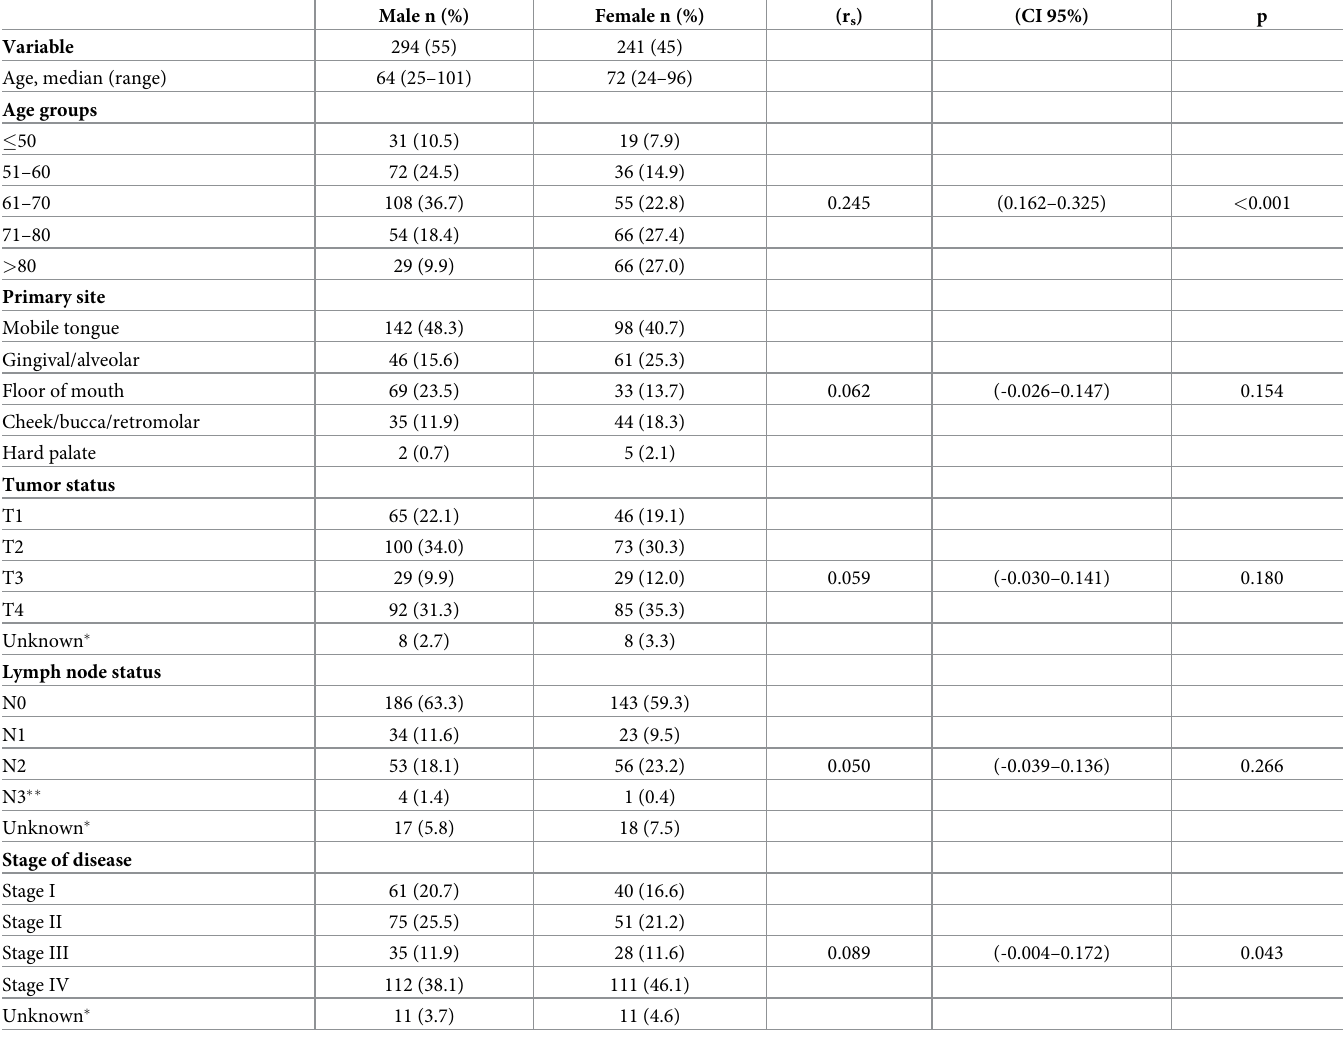
Table 1. Clinicopathological characteristics of 535 primary oral cavity squamous cell carcinomas